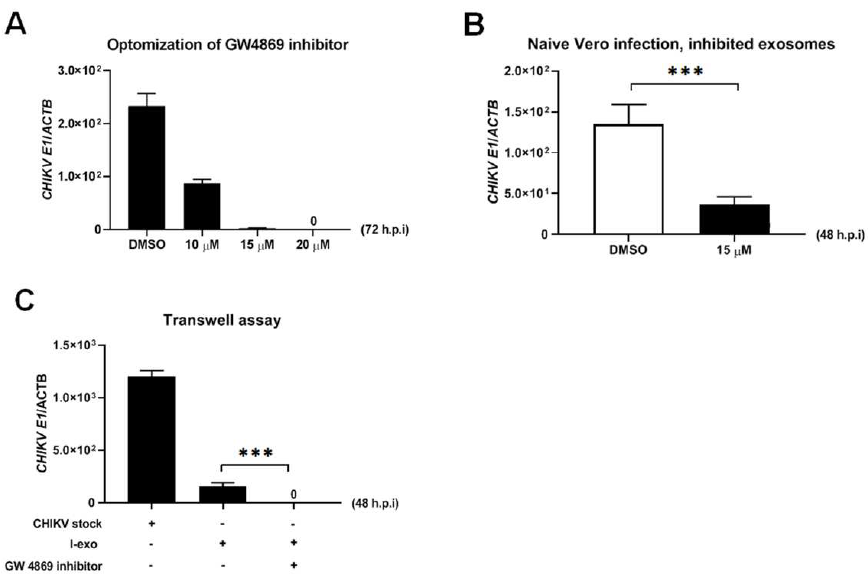
Figure 5. Role of the infectious EVs in CHIKV Cell − to − Cell transmission. ( A ) qRT − PCR anal- ysis representing CHIKV loads in exosomes derived from DMSO − or GW4869 − treated 5 MOI CHIKV − infected Vero cells at 72 h.p.i. ( B ) qRT − PCR analysis representing CHIKV loads in naïve Vero cells at 48 h.p.i., when treatment with exosomes derived from DMSO − or GW4869 − treated 5 MOI CHIKV − infected Vero cells at 72 h.p.i. ( C ) qRT − PCR analysis representing CHIKV loads at 48 h.p.i. in naïve Vero cells in a transwell assay. We performed with Vero cells in the upper chamber and naïve Vero cells in the lower chamber treated with exosomes derived from 5 MOI CHIKV-infected Vero cells at 72 h.p.i. for 4 h in the presence or absence of 20 µ M GW4869 inhibitor. Vero cells infected with CHIKV laboratory stocks with known titers were used as the based − line controls; ***, p <